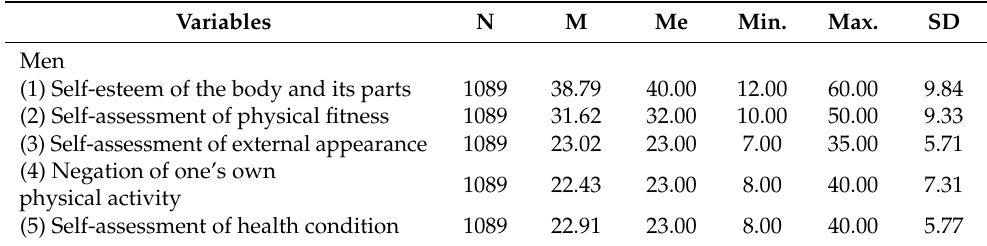
Table 6. Descriptive statistics of total results for individual subscales for the variables included in the MBRSQ-PL questionnaire in the research